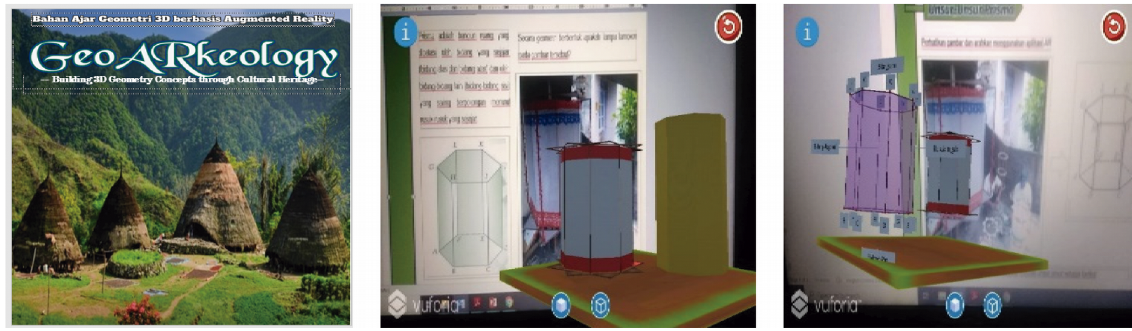
Figure 4. AR Textbook